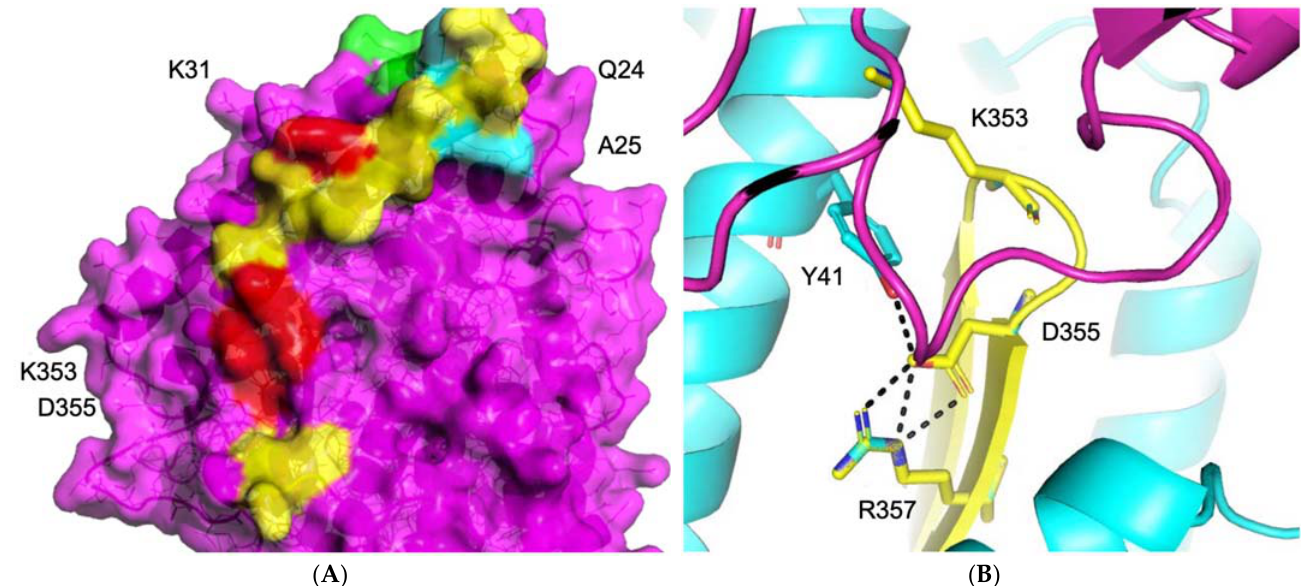
Figure 2. PPI region on the surface of ACE2 identifies key residues. ( A ) PPI region (yellow) on the surface of ACE2 is shown with important residues K353, D355, Y41, K31 highlighted in yellow. ( B ) Zoomed in detail panel shows beta sheet secondary structure and H-bond interactions targeted for disruption by docked small molecules.